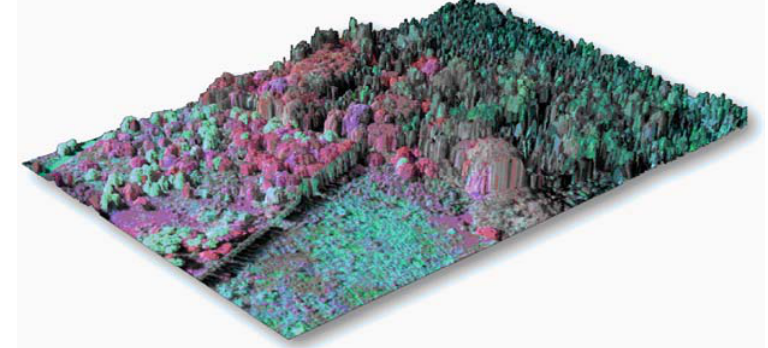
Figure 3. Demonstration of the precision co-alignment and integration of data collected by active (LiDAR) and passive (hyperspectral) remote sensing. This image was collected by the Carnegie Airborne Observatory over a site in Hawaii. The color-coding highlights variation among canopy species and their chemical properties both derived from the hyperspectral data. In this particular example, highly invasive species with unique chemical signatures are shown in red and pink colors, whereas native hardwood forest canopy species are shown in greens and blues. The embedded LiDAR data indicates the height and 3-D structure of each tree crown on the landscape.